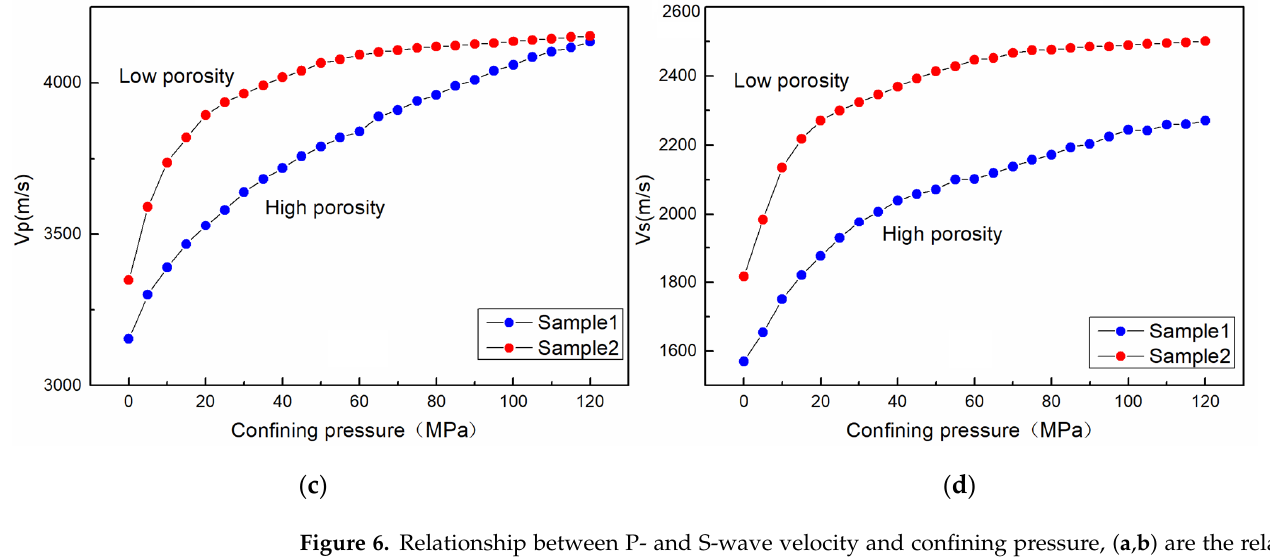
Figure 6. Relationship between P- and S-wave velocity and confining pressure, ( a , b ) are the rela- tionship between wave velocity and pressure under dry conditions, and ( c , d ) are the relationship between wave velocity and pressure under saturated conditions.